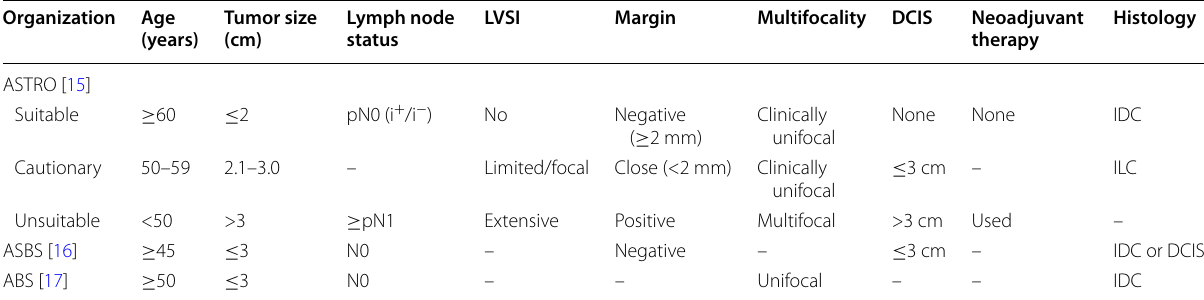
Table 2 Patient selection criteria for accelerated partial breast irradiation (APBI)